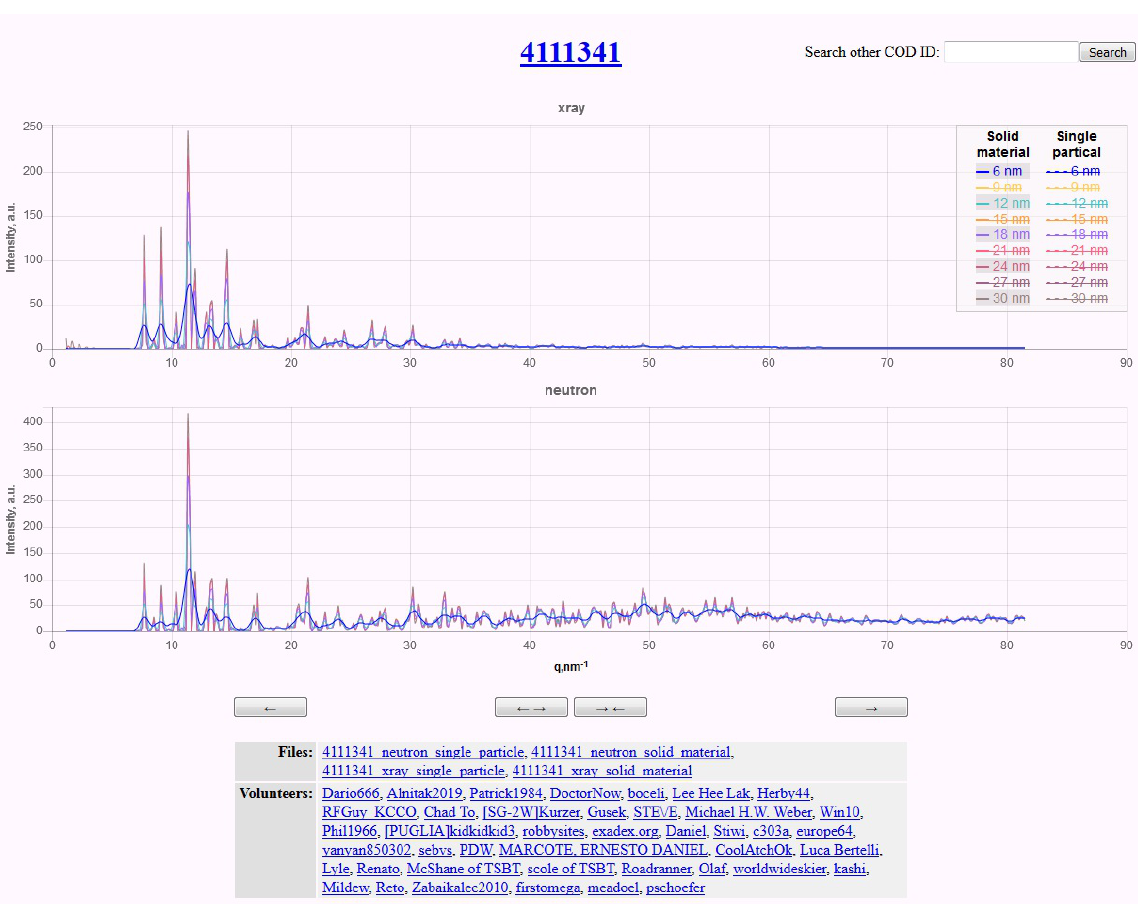
Figure 4: Screenshot of the webpage http://database.xansons4cod.com/4111341 for the structure with COD ID 4111341 (C 13 H 22 O 3